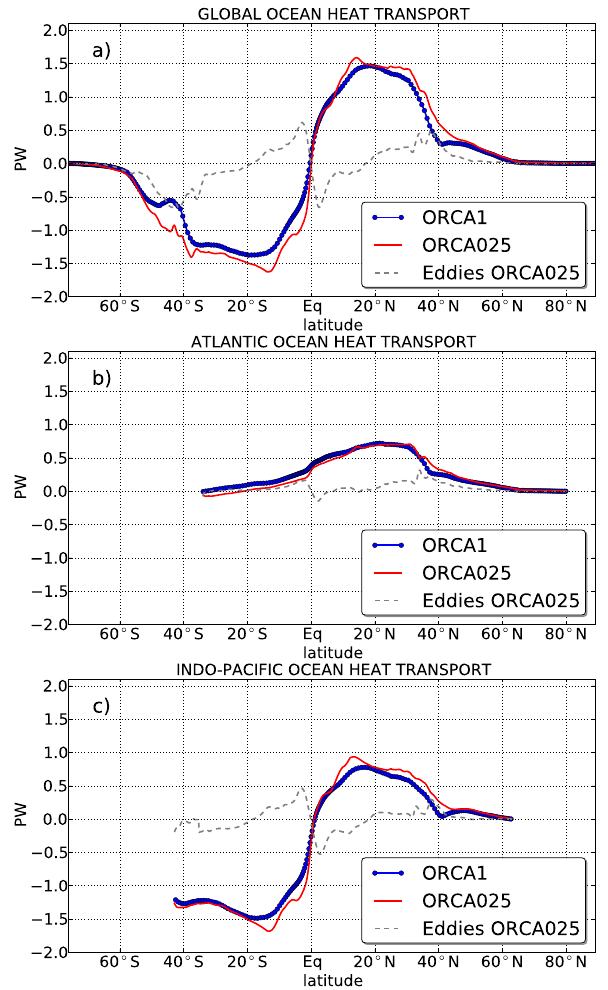
Fig. 8. Meridional ocean heat transport in the eddy-permitting (ORCA025) and coarse (ORCA1) resolution simulations for (a) the Global Ocean, (b) the Atlantic basin and (c) the Indo-Pacific basin. The dashed line represents the contribution of the eddies in the meridional heat transport. Units in PW=10 15